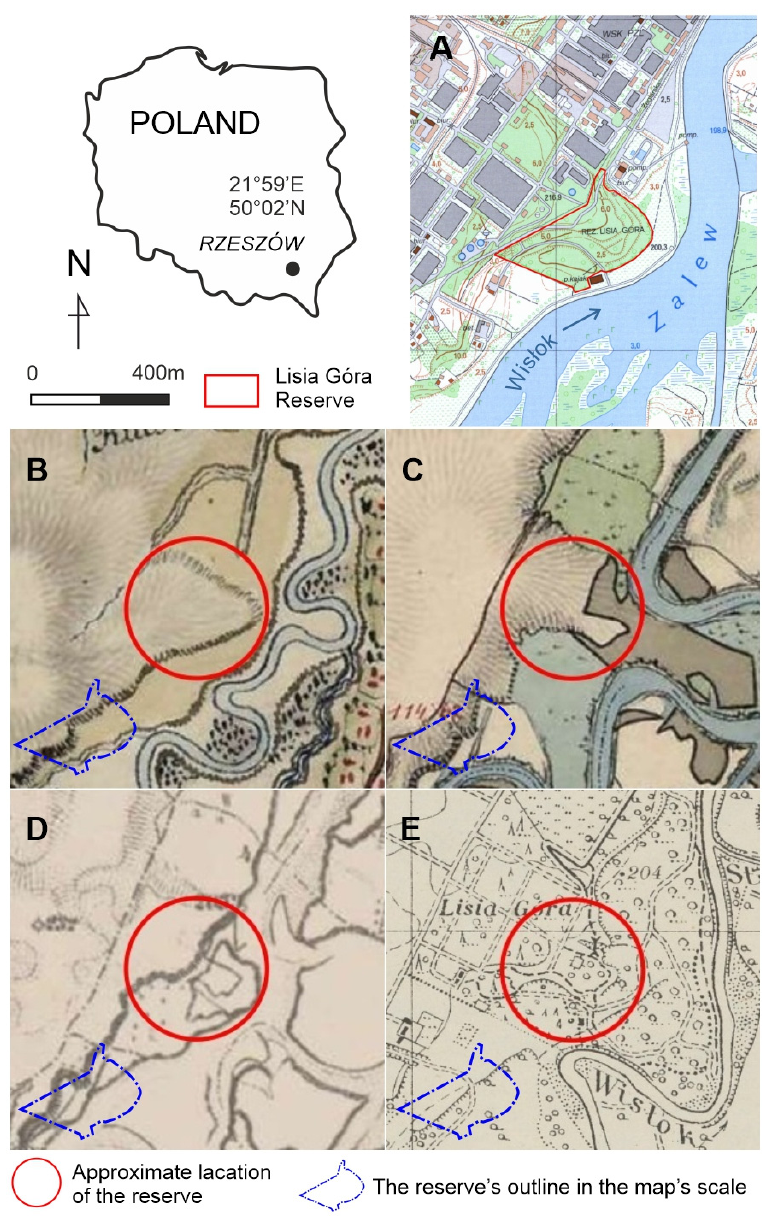
Figure 1. The study area: ( A )—present topography of the reserve’s location; ( B )—reserve’s approxi- mate surroundings according to First Military Survey (1779–1783), western part of the map—plough field, neighbouring to the east with grassland and wetlands, little patch of riparian forest in SE; ( C )—Second MS (1842–1853), NW of the square—plough field, CE—riparian woods, SW—grassland with single trees; ( D )—Third MS (1869–1887), NW—arable land, SE—pasture and woodland; ( E )—Polish Military Map (1938) compartmentalized park and woodland; Maps provided by Main Office for Geodesy and Cartography, Poland ( A ), Arcanum, https://maps.arcanum.com/, accessed on 28 August 2021 ( B – D ), and Mapsters, http://igrek.amzp.pl/mapindex.php?cat=WIG25, accessed on 28 August 2021 ( E